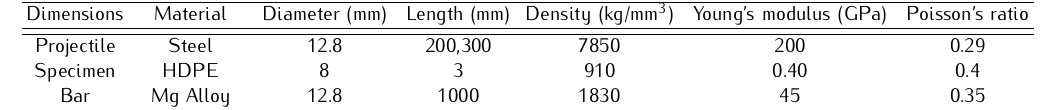
Table 1. Dimensions and mechanical properties used for the FEA model.